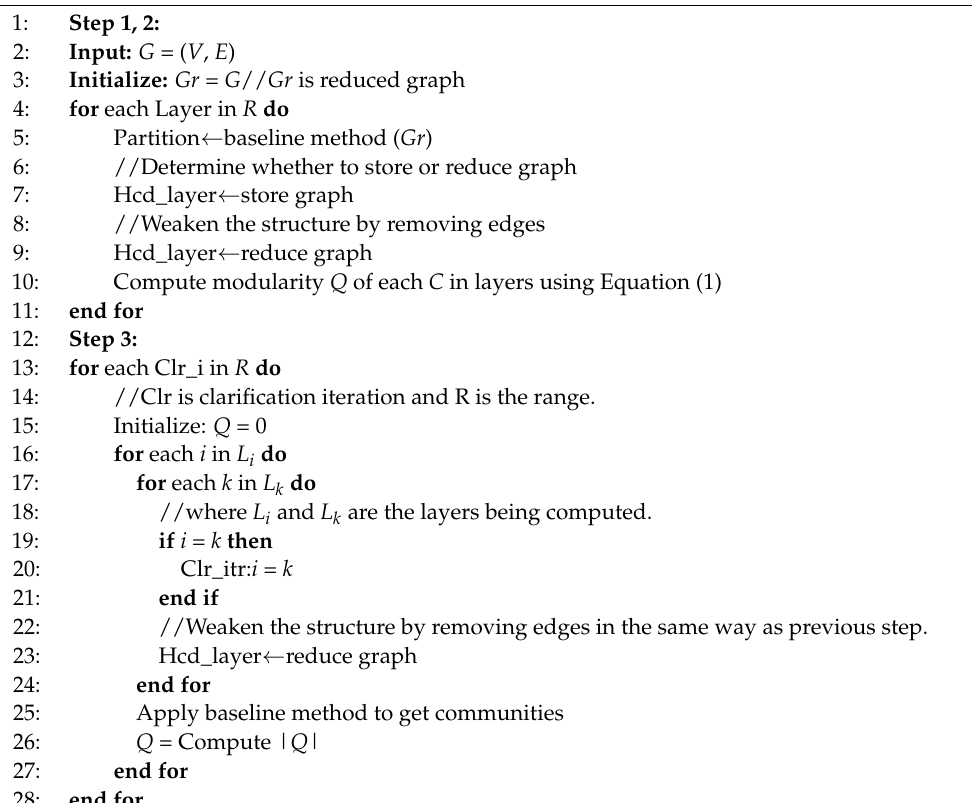
Algorithm 1. Hidden Community Detection: Basic